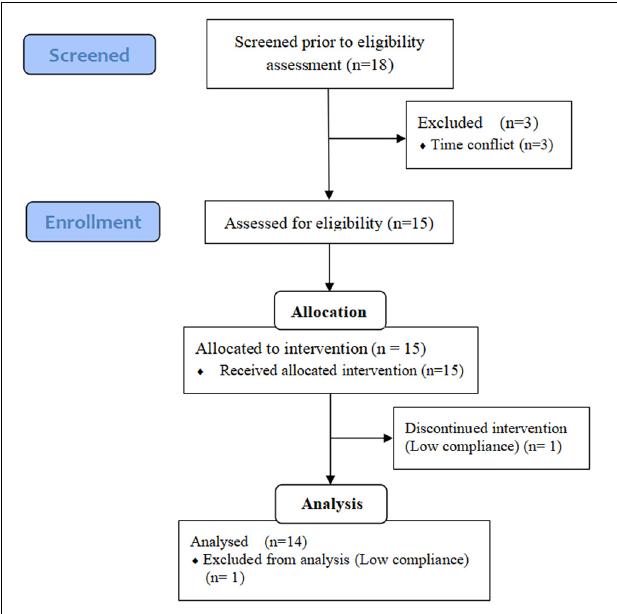
FIGURE 1 | Flow diagram of the study selection process. Adapted from